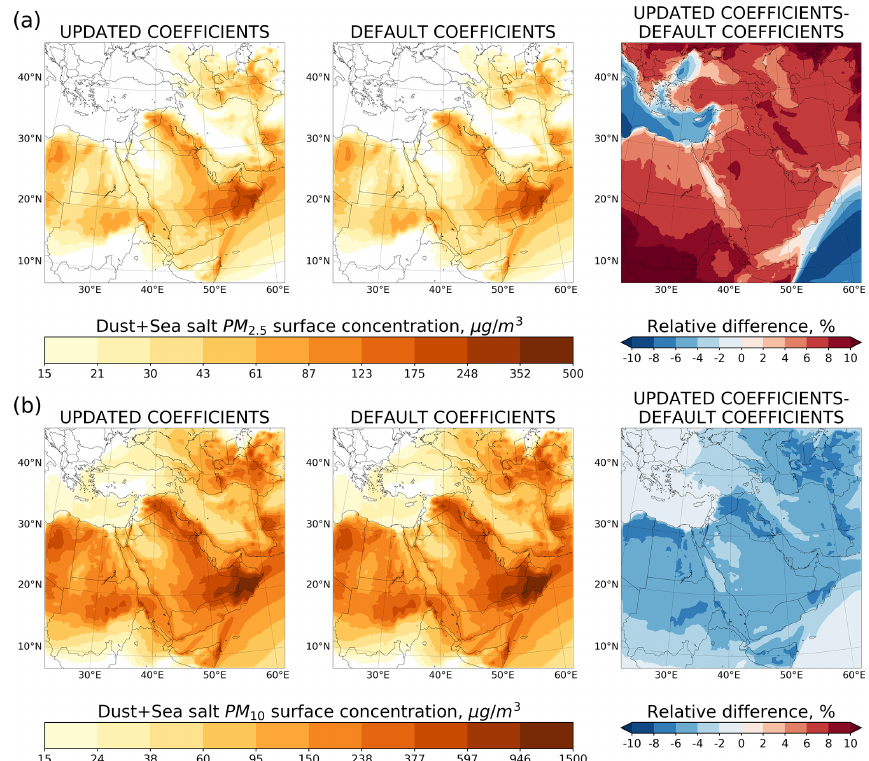
Figure 2. Average dust and sea salt PM 2 . 5 (a) and PM 10 (b) surface concentration (µgm − 3 ) calculated using default and updated coefficient values and relative difference (%). Table 4. Dust mass redistribution between GOCART and MOSAIC bins before and after inclusion of dust particles with radii ≥ 0.1µm into calculation of aerosol optical